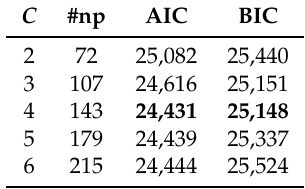
Table 6. Data illustration polytomous data: model comparison for exploratory LCMs.